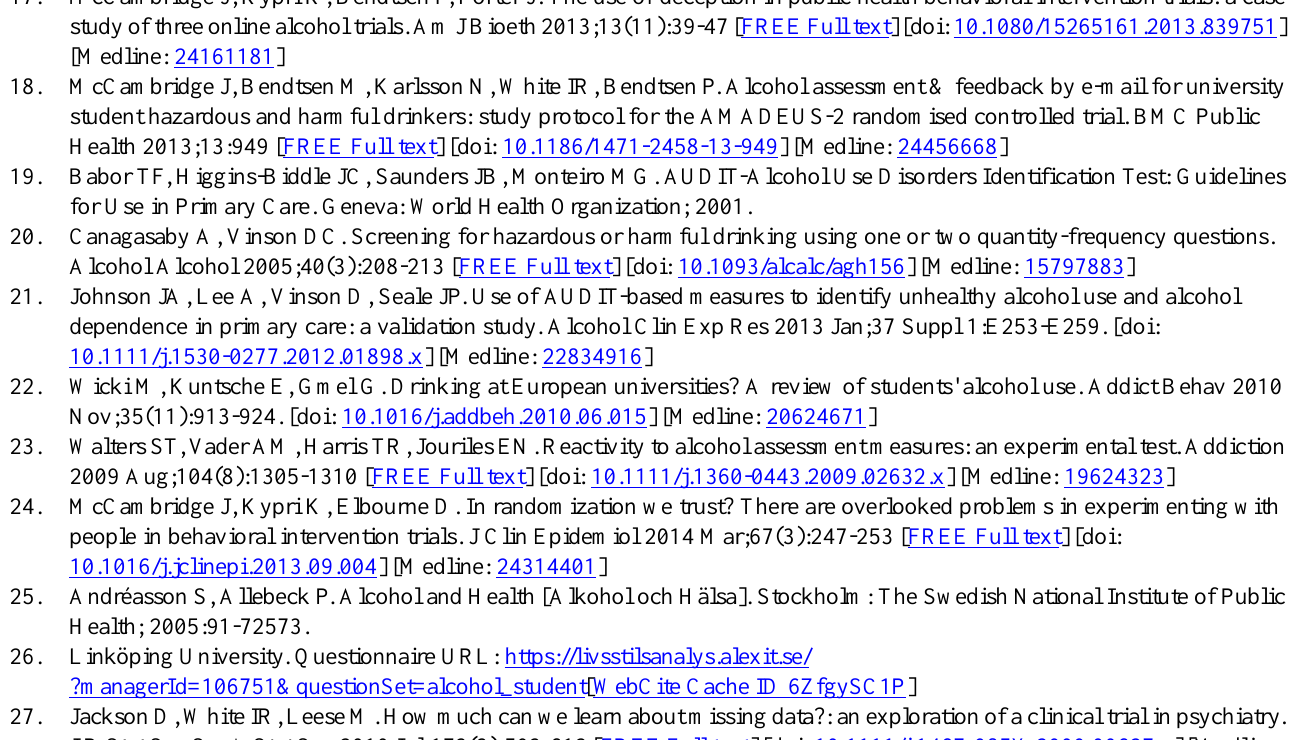
Abbreviations AUDIT: Alcohol Use Disorders Identification Test eBAC: estimated blood alcohol concentration HED: heavy episodic drinking